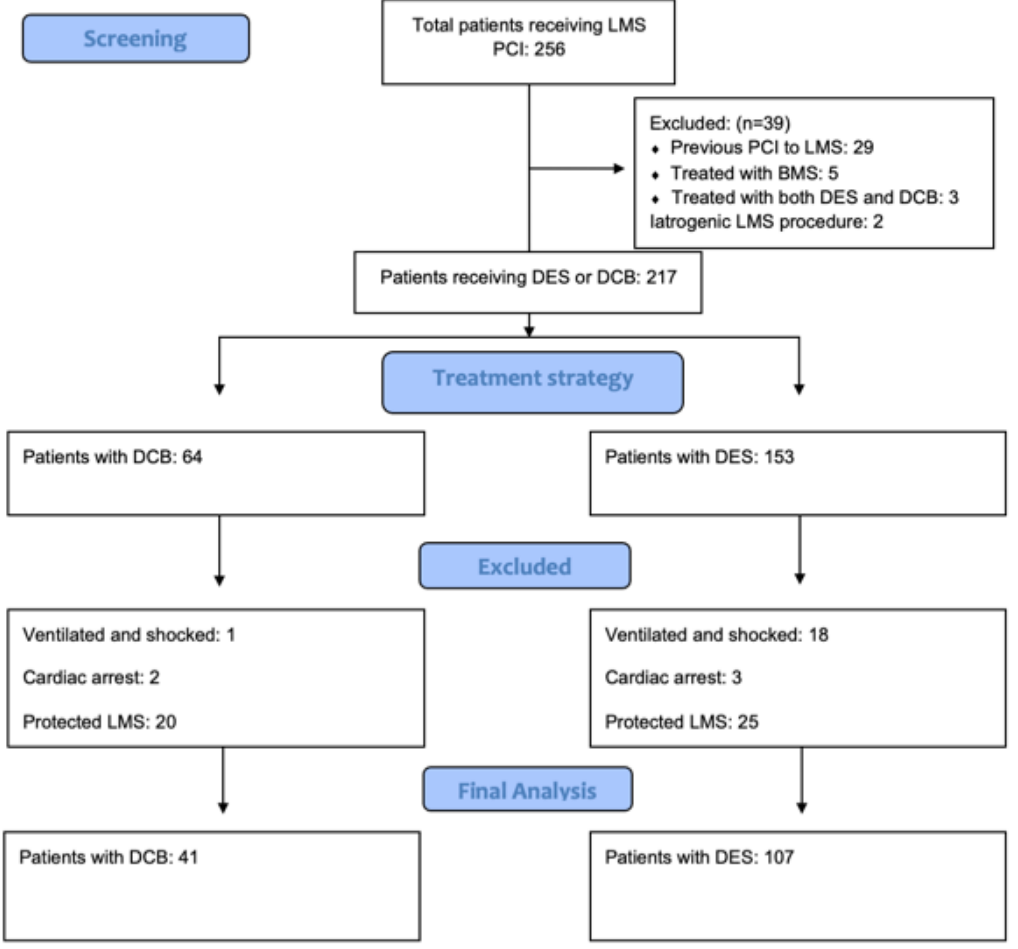
Figure 1. Study composition—a diagram to demonstrate the exclusions to form the final study co- hort. Table 1. Baseline characteristics of the patient groups.